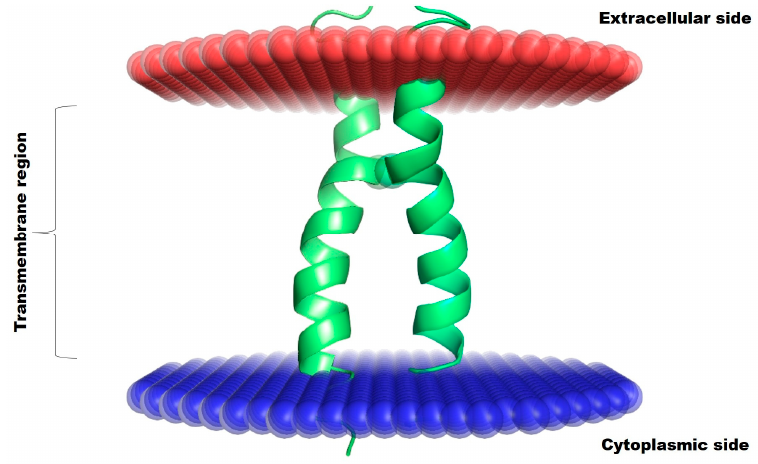
Figure 2. Spatial position of the nuclear magnetic resonance (NMR) structure of the human FGFR3 transmembrane domain dimer (PDB ID: 2LZL) with respect to the lipid bilayer. The two glycyl residues, which have been substituted with the arginyl residues in the achondroplastic child, are shown as spheres. The transmembrane helices of the FGFR3 monomers are colored in pale green and bright green, respectively.